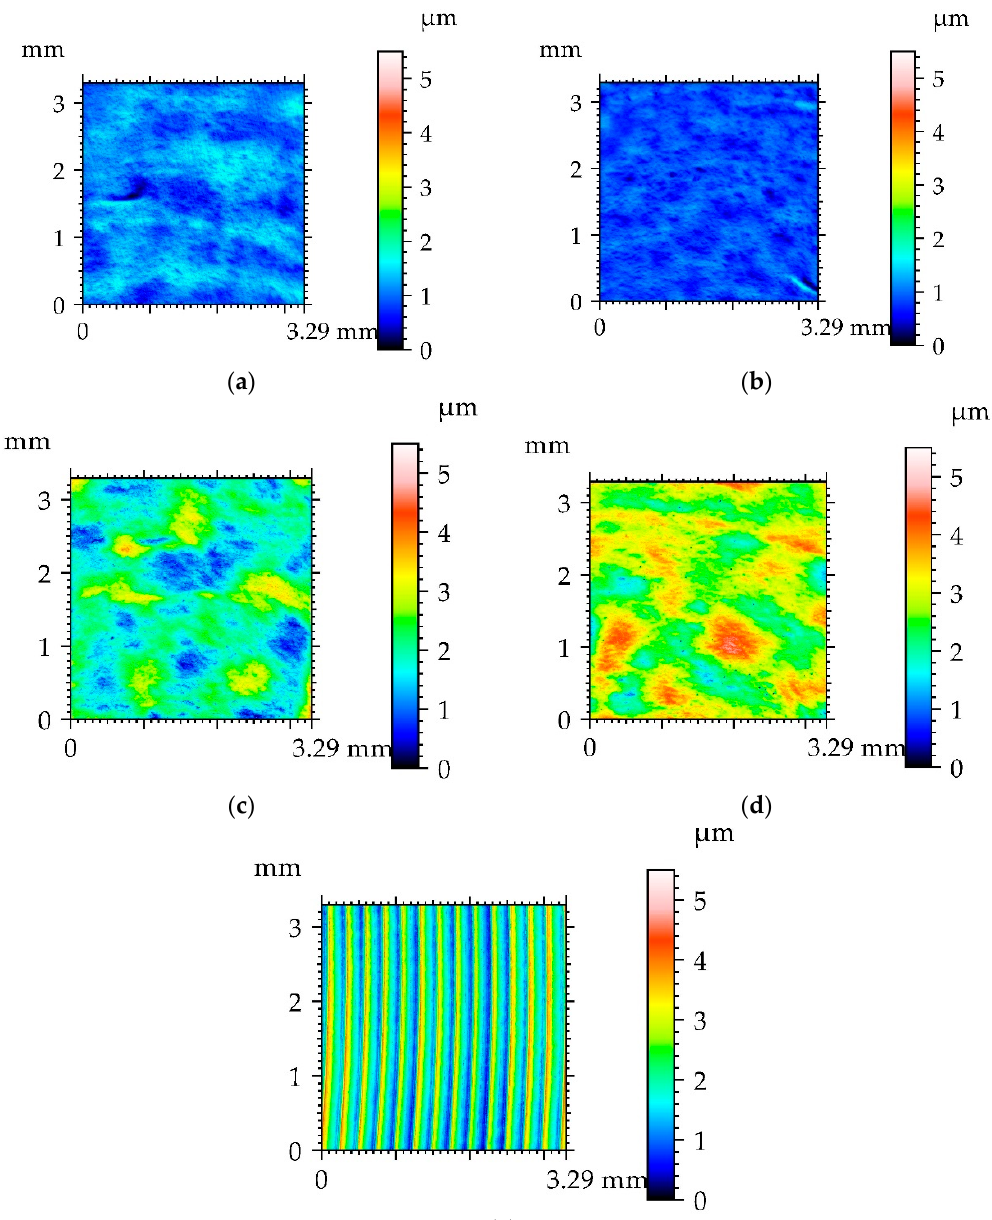
Figure 2. Contour plots of disc surfaces after burnishing with a pressure (P) of 10 MPa ( a ), 20 MPa ( b ), 30 MPa ( c ), 40 MPa ( d ) and after milling ( e ).